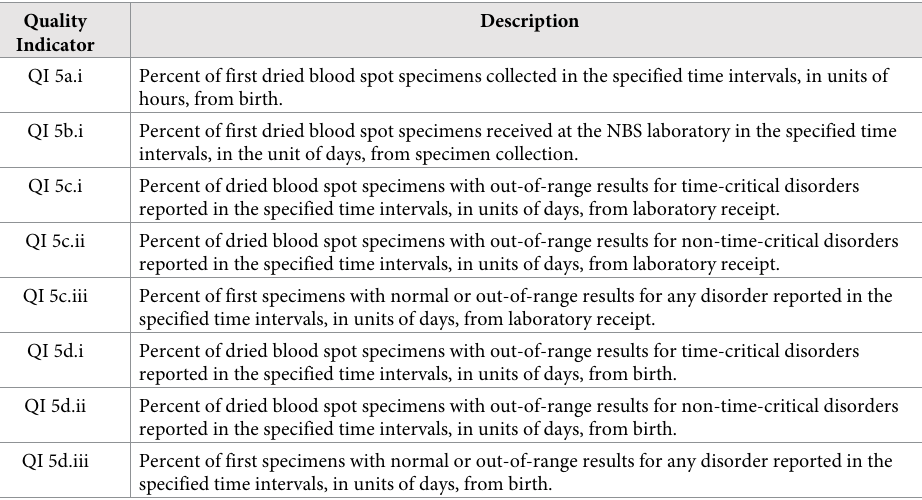
Table 2. NewSTEPs Data Repository quality indicator 5: NBS timeliness from collection to reporting results. Excerpted from NBS quality indicator panel.